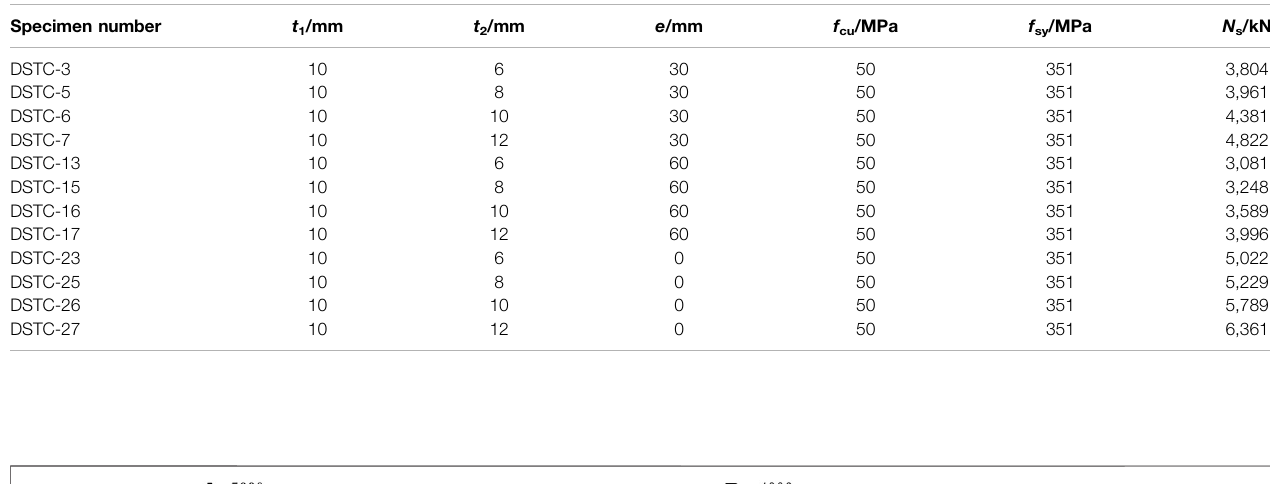
Frontiers in Materials |